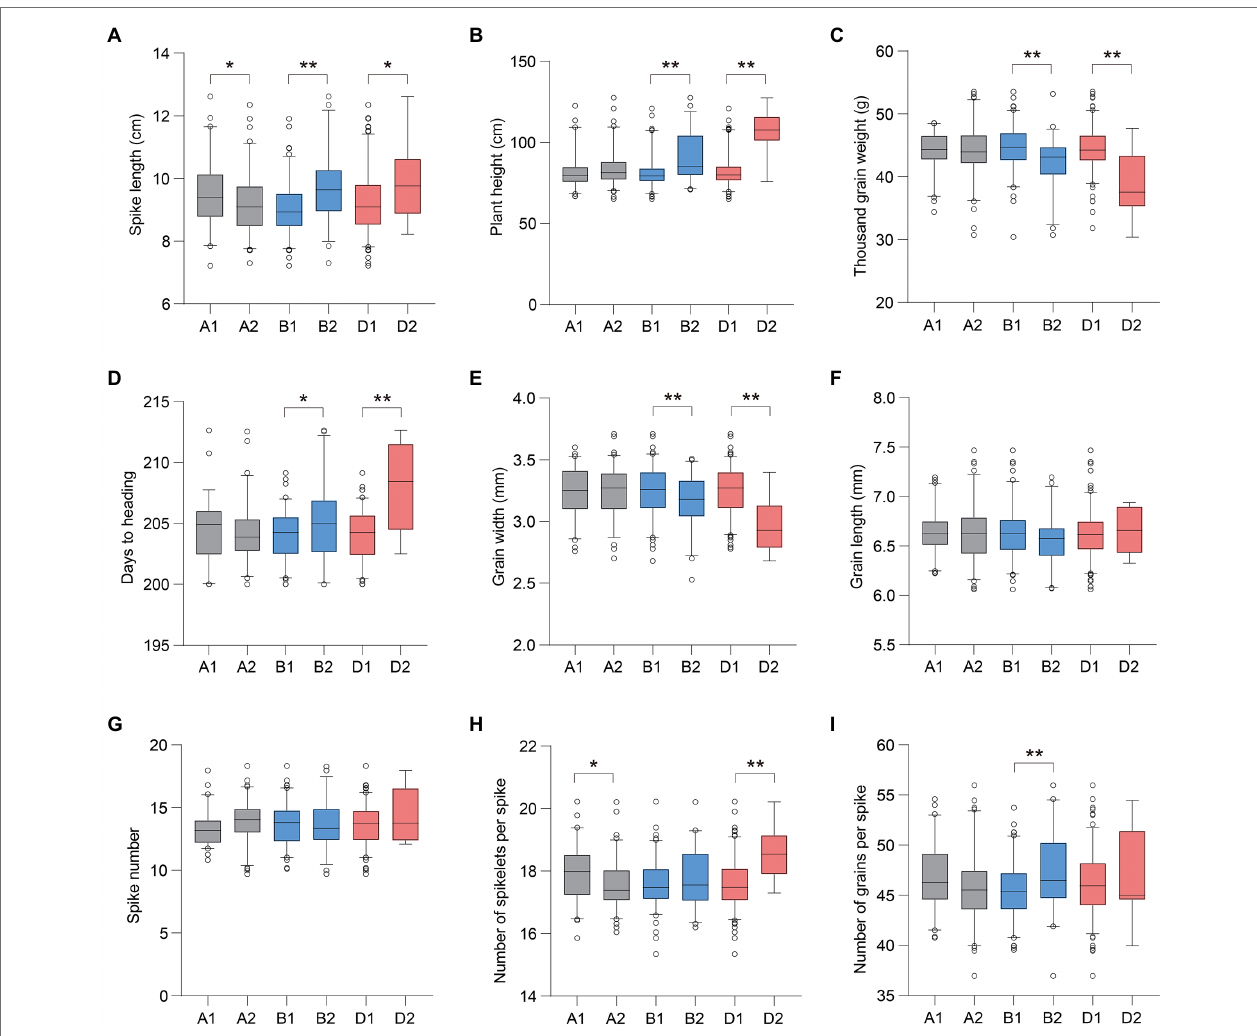
FIGURE 4 | Phenotypic comparisons of large-effect haplotypes of Ppd-1 homeologs. The phenotypic values of SL, PH, TGW, days to heading, GW, GL, SN, NGS, and number of grains per spike of different Ppd-1 haplotypes are shown in (A–I) , respectively. A total of 188 wheat accessions were used for phenotypic data analysis. The accessions were separately planted in Qixia (121.07 ° E, 37.49 ° N), Weifang (119.44 ° E, 36.68 ° N), Pulagu (121.41 ° E, 37.31 ° N), Shijiazhuang (114.69 ° E, 37.89 ° N), and Ludong University (121.35 ° E, 37.51 ° N) during the years 2017–2020. The test locations are all located in the northern part of China, with long-day conditions. The best linear unbiased estimate (BLUE) mean of two replicates under each environment was estimated using mixed liner model by regarding accession as fixed effect and replicates as random effect. Data for different phenotypic traits are represented by boxplots using the BLUE mean under each environment. The horizontal solid line represents the median. The upper and lower edges of the box represent the upper and lower quartiles, respectively. The short thin lines represent the maximum and minimum values. The circle represents the outliers. * p < 0.05, ** p <